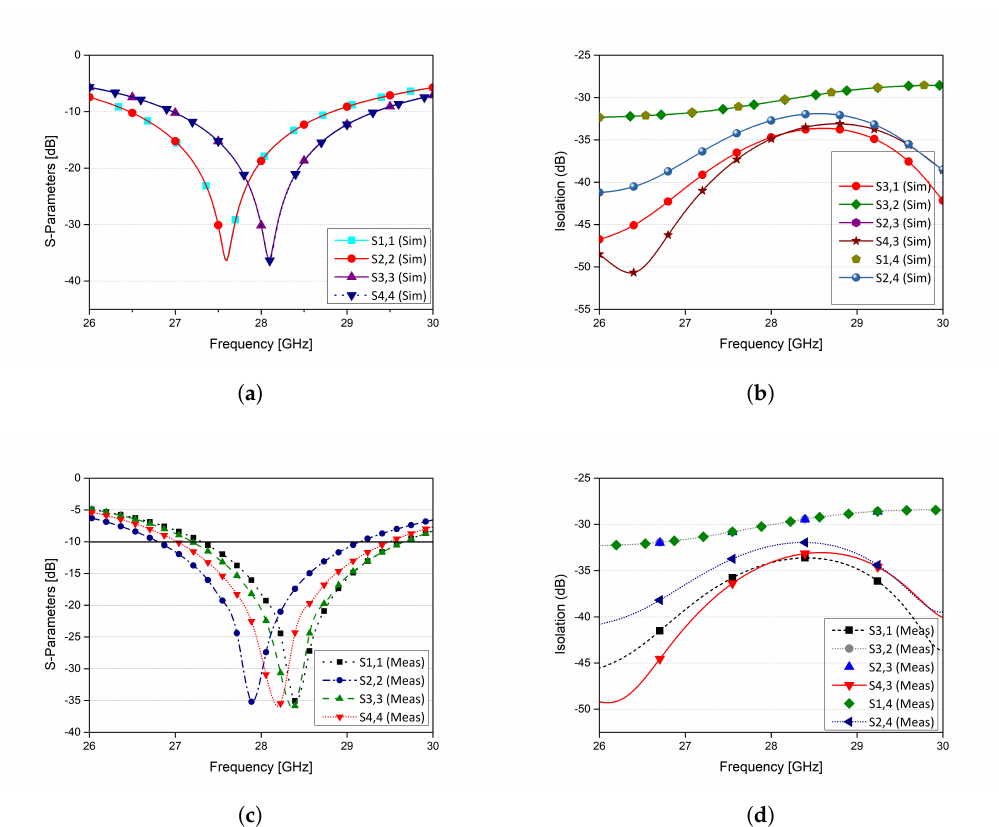
Figure 5. ( a ) Reflection coefficient of the proposed MIMO configuration, ( b ) simulated port isolation, ( c ) measured reflection coefficient of the proposed MIMO configuration, ( d ) measured port